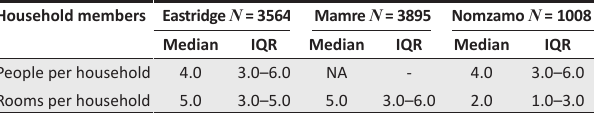
TABLE 1b: Demographics of population and characteristics of